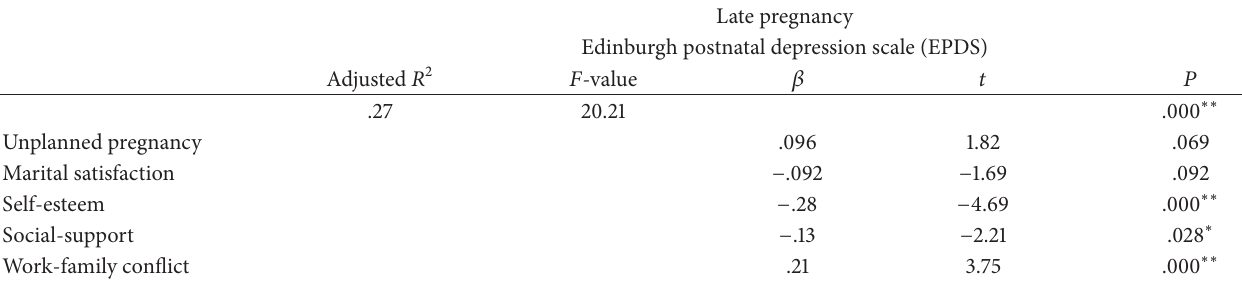
Table 6: Hierarchical multiple regression analysis of significant psychosocial risk factors for EPDS scores in late